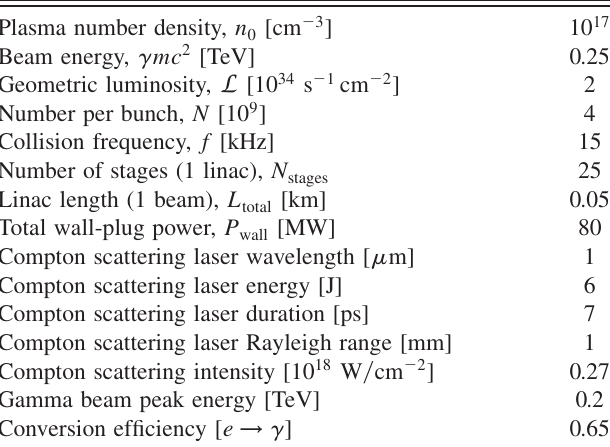
TABLE II. Example parameters for a 0.5 TeV laser-plasma linear (cid:4)(cid:4)